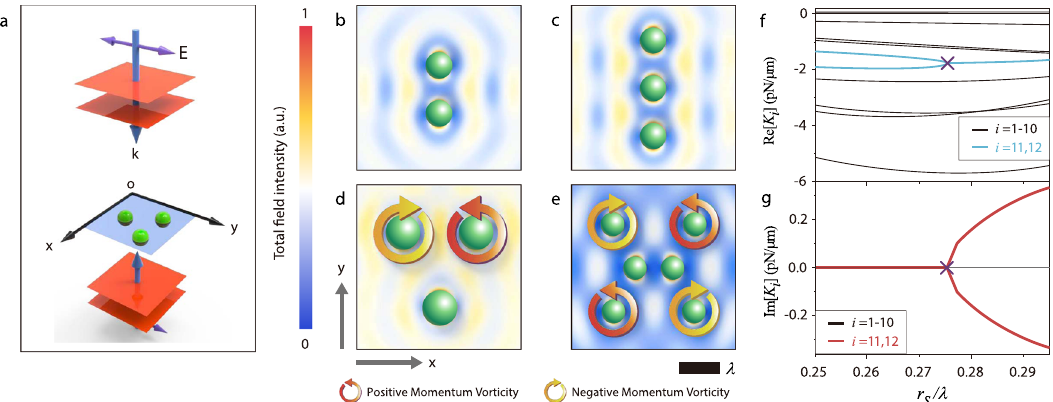
Fig. 2 Exceptional points in optical binding. a Schematic of a pair of counter-propagating plane waves that are applied to con fi ne particles on the xy plane. Despite the incident light intensity is uniform over the xy plane, the scattering of light among the spheres modi fi es the spatial light distribution, as shown in b – e , which induces binding forces. The colored contour plots in b – e represent the normalized total fi eld intensity for the spheres with b r S ¼ 0 : 31 λ and ¼ 1 : 2, c r ¼ 0 : 31 λ and n ¼ 1 : 2, d r ¼ 0 : 41 λ and n ¼ 1 : 2, and e r ¼ 0 : 27 λ and n ¼ 1 : 51. All fi gures are drawn to scale. Red (yellow) circles denote n r S r S r S r positive (negative) momentum vorticity C (see main text) near each sphere. f – g plot the real ( f ) and imaginary ( g ) components of the eigenvalues for the force matrix of e against the particle radius. The exceptional point is marked by purple